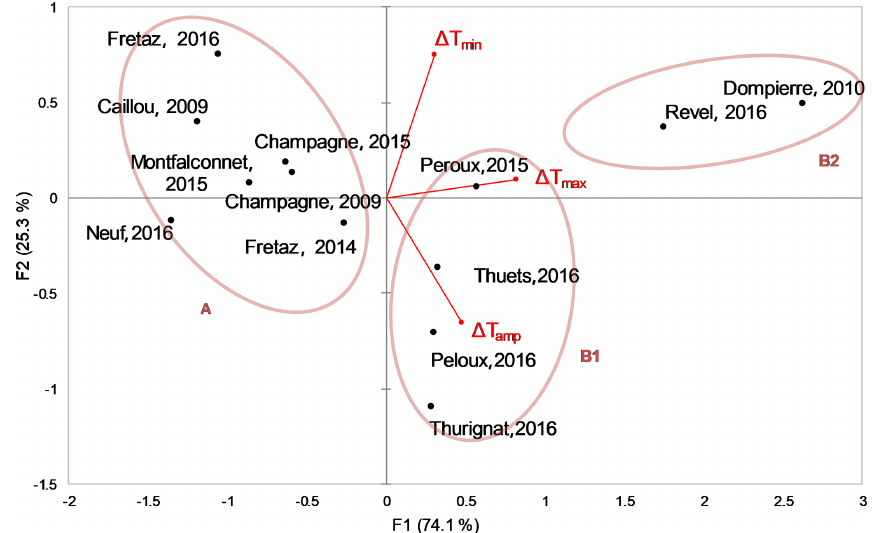
Figure 6. PCA analysis with sites plotted and temperature anomaly variables shown. Ellipses are drawn to visualize the groups obtained with the hierarchical cluster analysis.